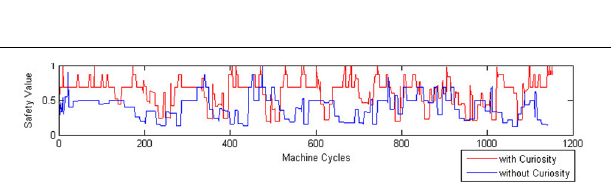
FIGURE 9 | Safety function comparison.